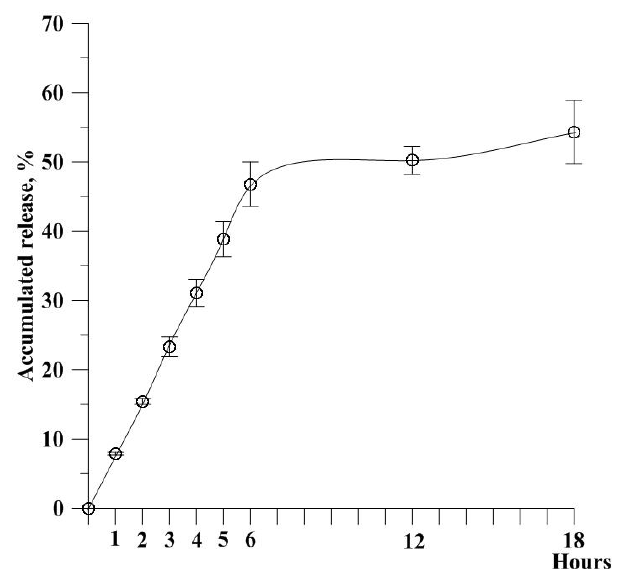
Figure 3. In vitro release profile of Astaxanthin (Asta) from AHAna aggregates in phosphate buffered saline (PBS) (pH 7.4). Values are mean ± standard error of the mean (SEM).